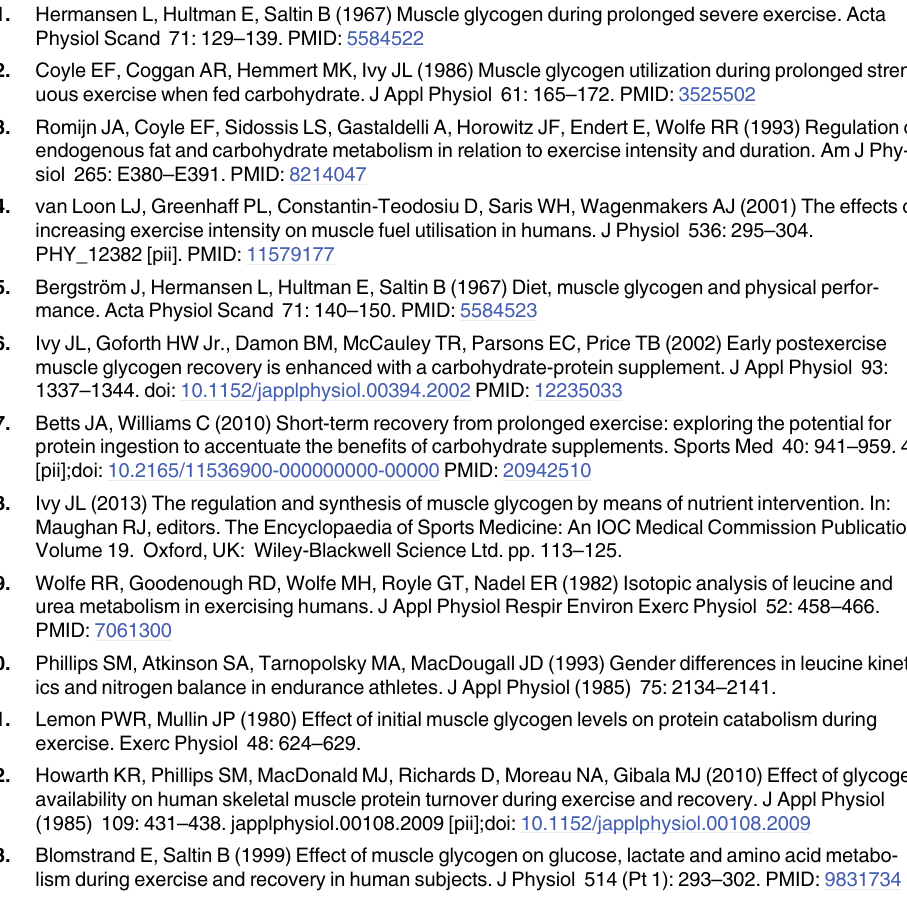
S5 Table. Plasma LDH, CK and MYO after exhaustive exercise and during the recovery period and after the performance